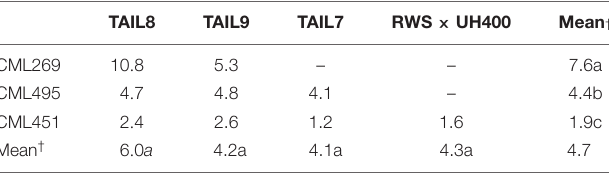
TABLE 2 | Least square means of HIR in qhir1 + families of different non-inducer and inducer